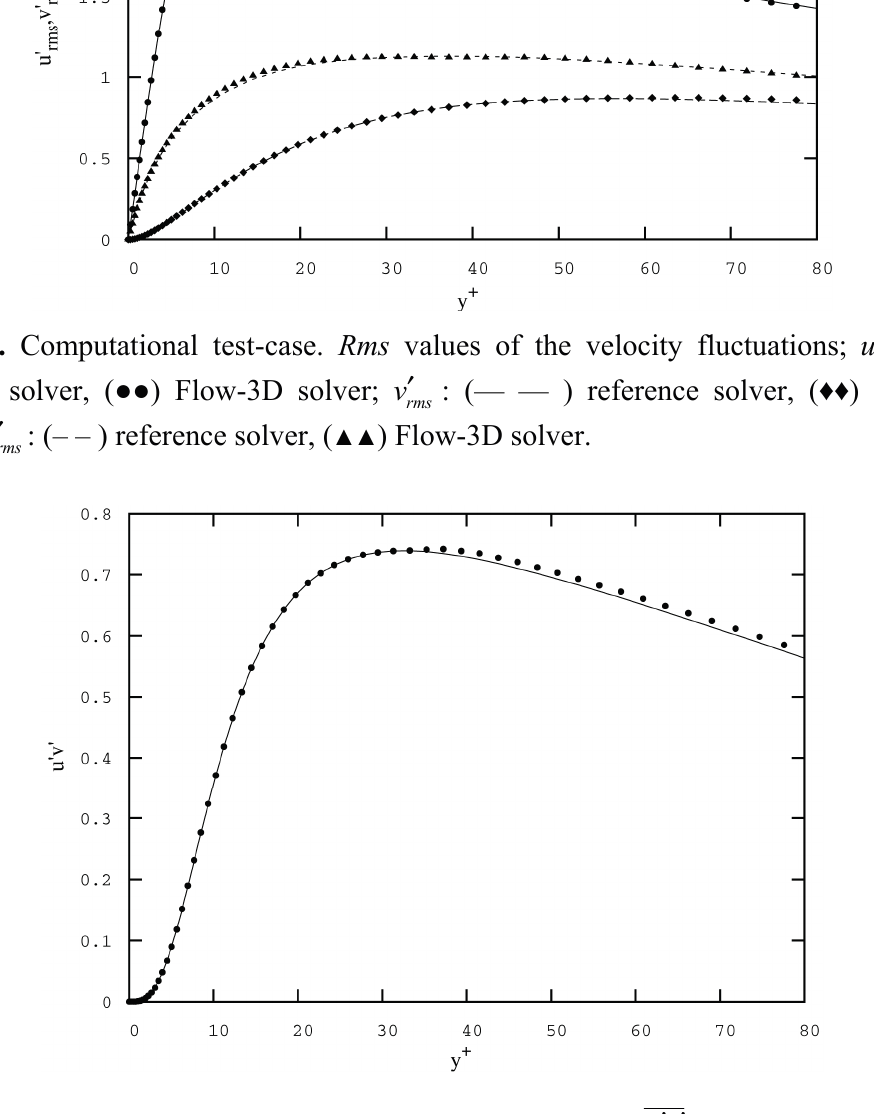
Figure 6. Computational test-case. Reynolds shear stress; u v ′ ′− : (—) reference solver, ( ●● ) Flow-3D